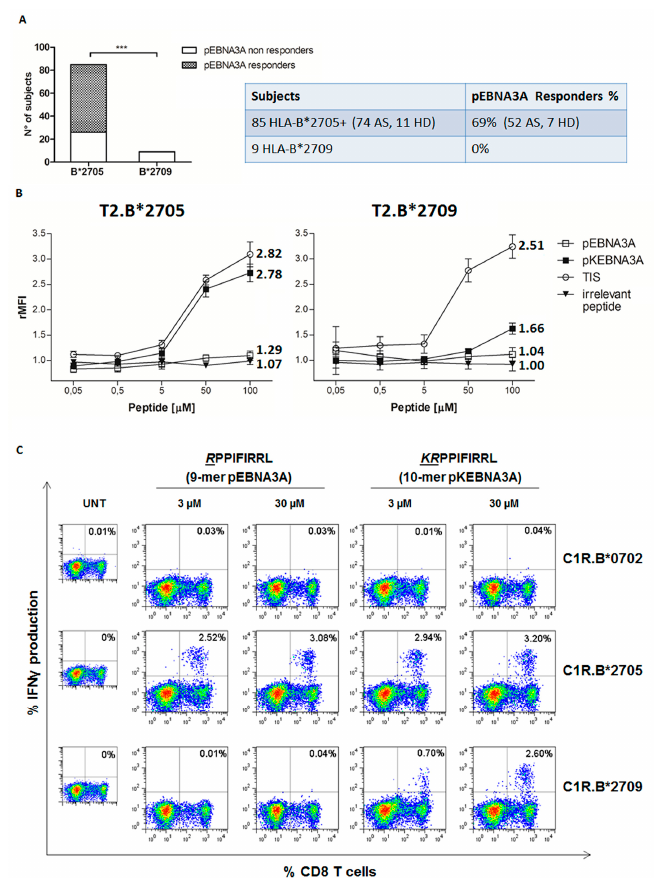
Figure 1. B*2705 but not B*2709-positive carriers mount a response to the 9-mer pEBNA3A epitope. ( A ) CD8+ T cell responses to pEBNA3A detected by IFN γ production analyzed in 85 B*2705 carriers (74 patients with Ankylosing Spondylitis, indicated as AS, and 11 healthy donors, indicated as HD) and in 9 B*2709 healthy donors. 69% of B*2705 carriers but none of B*2709 individuals show reactivity against pEBNA3A antigen (p value < 0.0001 calculated by Fisher’s two-tailed exact test). ( B ) Staining of B*2705 and B*2709 molecules expressed on the cell surface of T2 transfectants performed by using ME1 mAb after 16 h of cell incubation with pEBNA3A, pKEBNA3A, or TIS (RRLPIFSRL) used as positive reference as well as with an irrelevant peptide at the indicated concentrations. Results are expressed as relative mean fluorescence intensity (rMFI) obtained with peptide-treated compared to untreated cells. Values represent the mean ± SEM of three independent experiments. The numbers on the right indicate the fold increase of rMFI obtained with 100 µ M compared to 0.5 µ M of each peptide. ( C ) Flow cytometry plots reporting IFN γ production by PBMCs from a representative B*2705 positive patient with AS expanded in the presence of pEBNA3A (12 days) and exposed to indicated C1R transfectants pulsed with pEBNA3A or pKEBNA3A (3 or 30 µ M) before intracellular staining. Numbers indicate the percentage of IFN γ -secreting CD8 + T